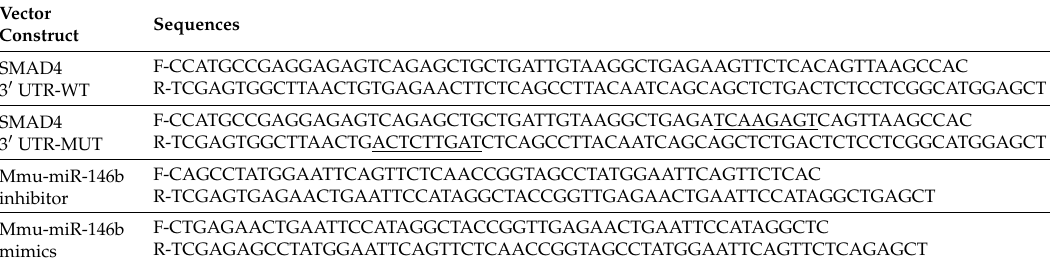
Table 4. The sequences for the vector constructs of SMAD4 3 (cid:48) UTR-WT, SMAD4 3 (cid:48) UTR-MUT, Mmu-miR-146b inhibitor and Mmu-miR-146b mimic. The mutation parts in the sequences of SMAD4 3 (cid:48) UTR-MUT are highlighted with double